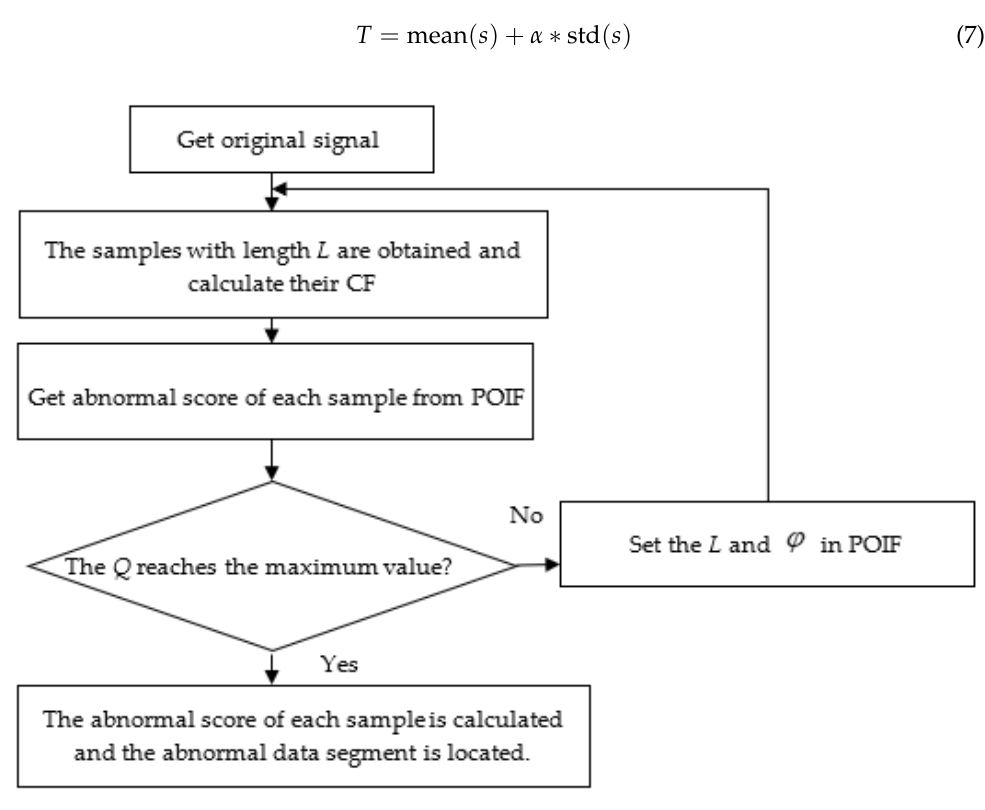
Figure 7. Flow chart of the proposed CF-POIF.